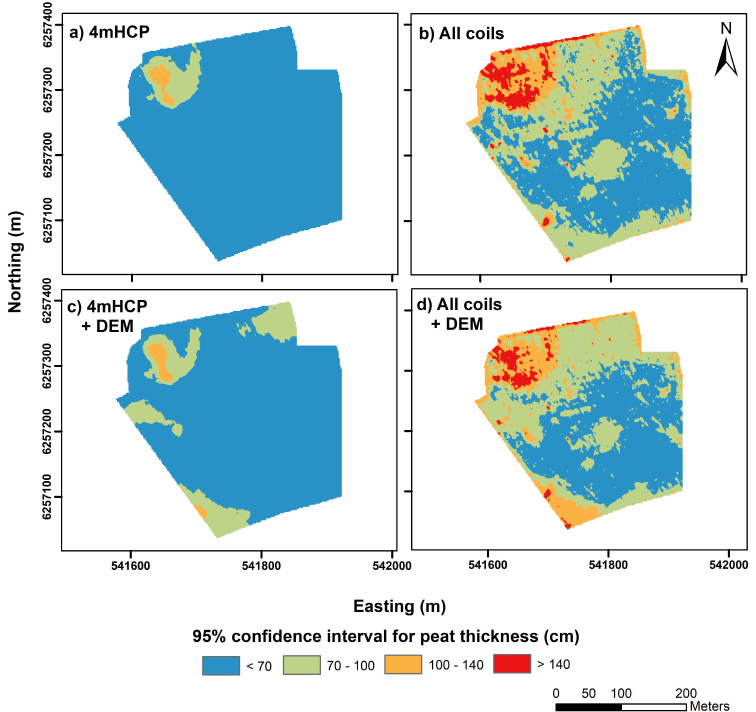
Figure 14. Plots of 95% confidence intervals for the peat thickness (cm) predicted from ( a ) 4mHCP, ( b ) the combination of all six coils, ( c ) the combination of 4mHCP and the DEM and ( d ) the combination of all six coils and the